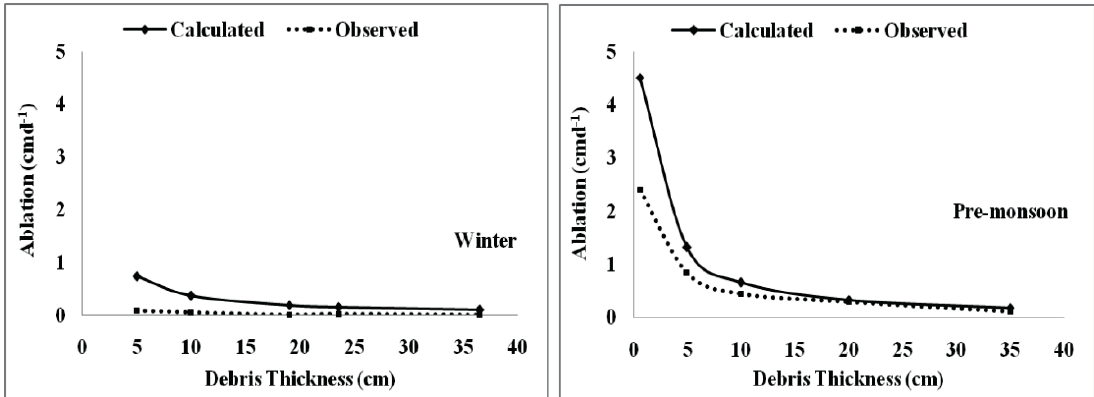
Fig. 4 Comparison of observed and calculated daily ice ablation during the winter season, and during the pre-monsoon season; square and lines with dots indicate the observed and calculated ice ablation,